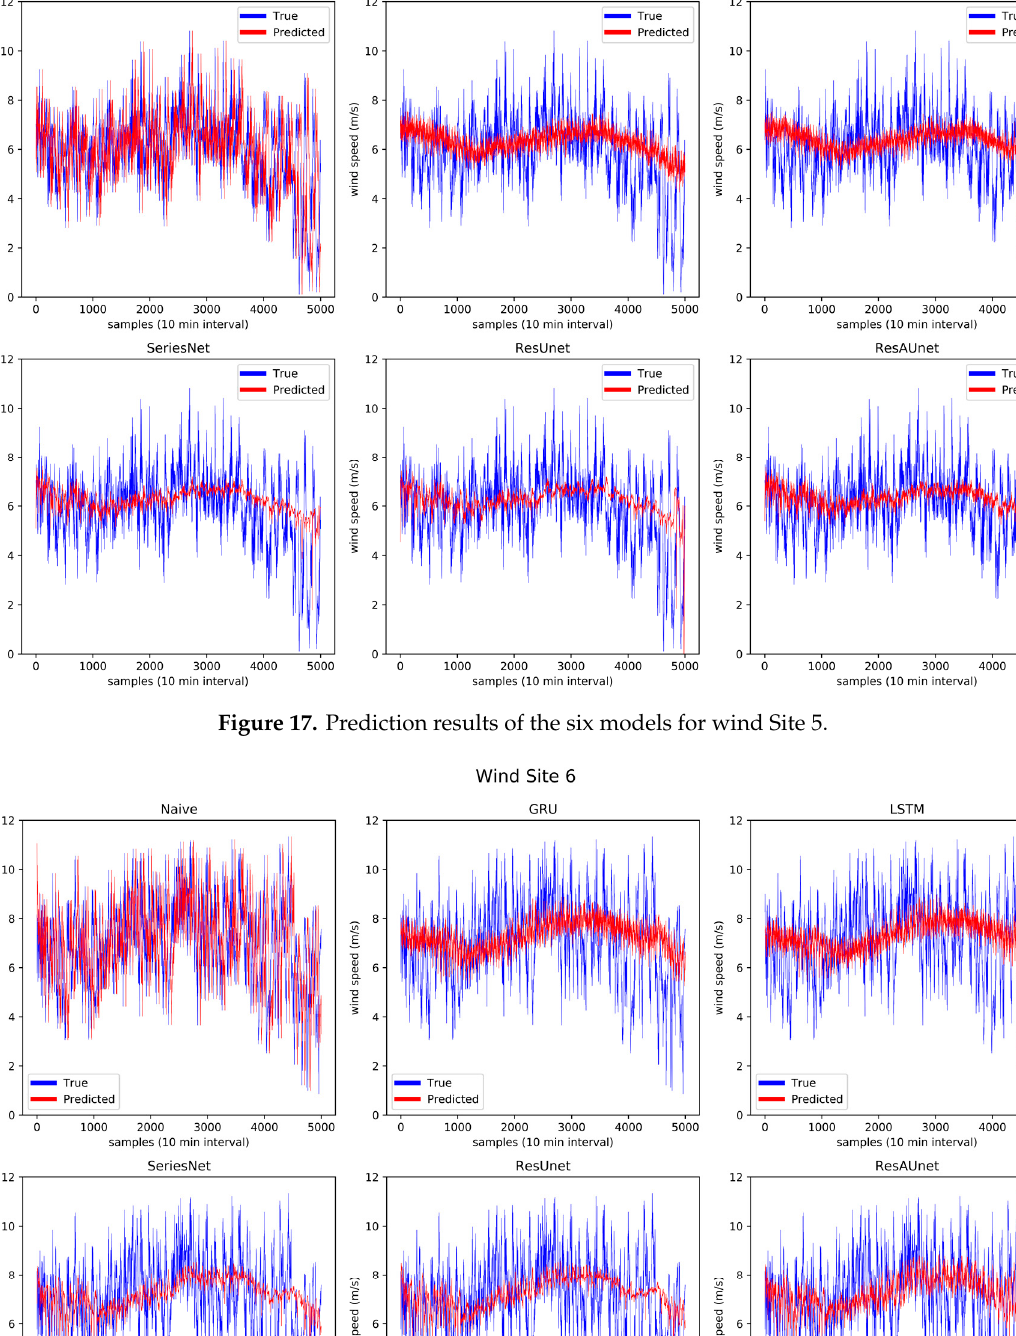
Figure 16. Prediction results of the six models for wind Site 4.